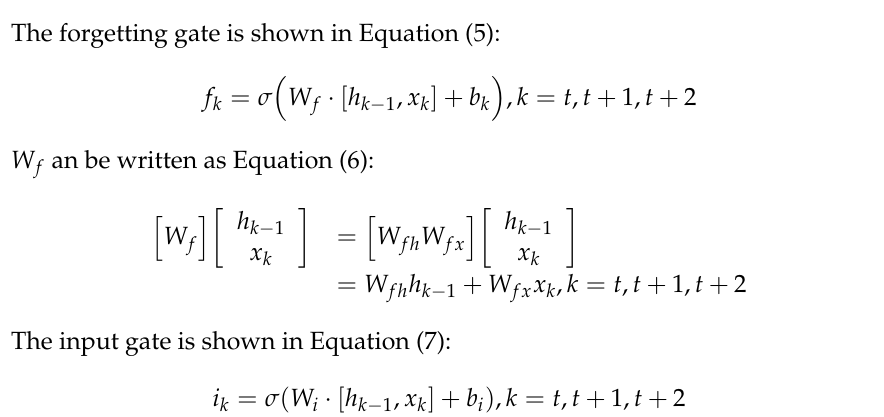
Figure 7. LSTM is expanded in time dimensions.